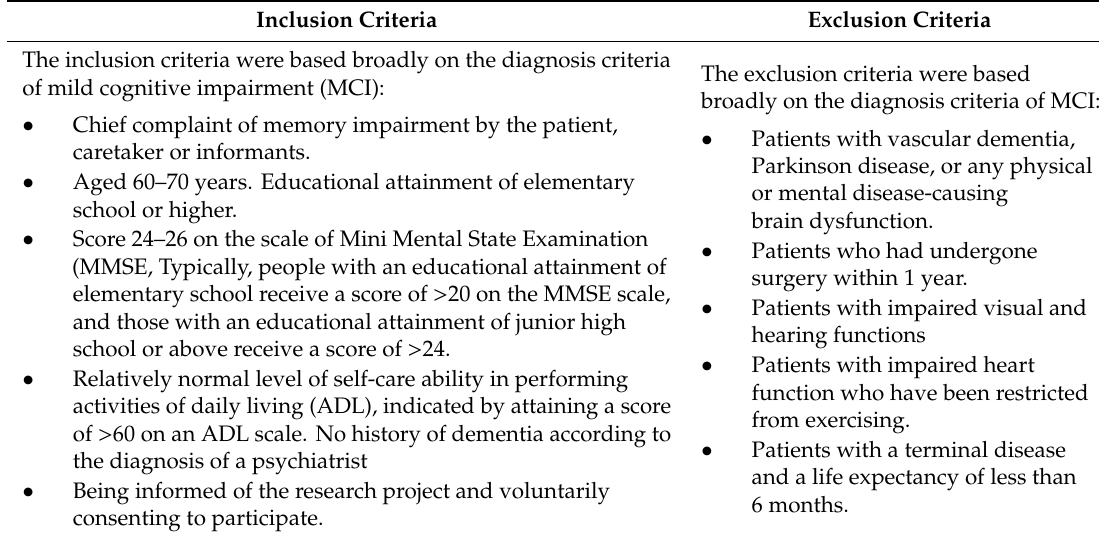
Table 1. Inclusion criteria and exclusion